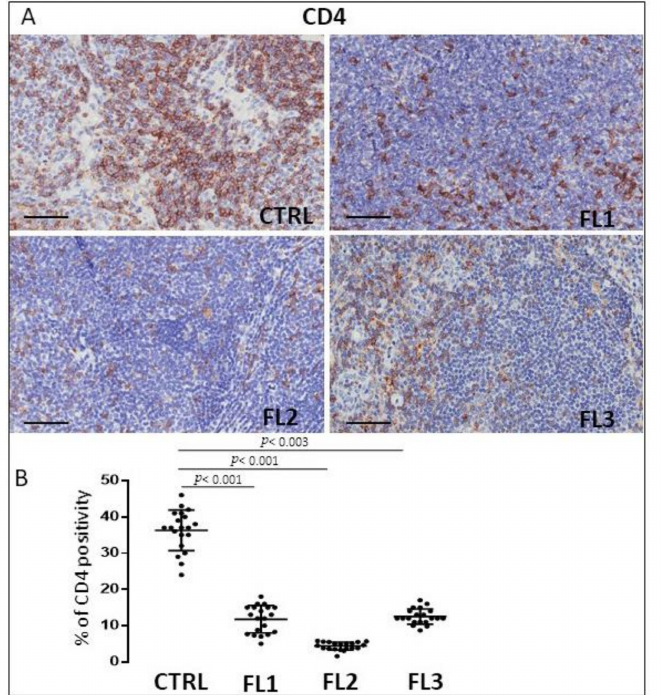
Figure 4. Immunohistochemical staining for CD4 in FL grade1 (FL1), FL grade2 (FL2), and FL grade 3 (FL3) and control samples (CTRL). Scale bar: 60 µ m ( A ). Morphometric analysis indicates the percentage of CD4 positivity in FL and CTRL samples ( B